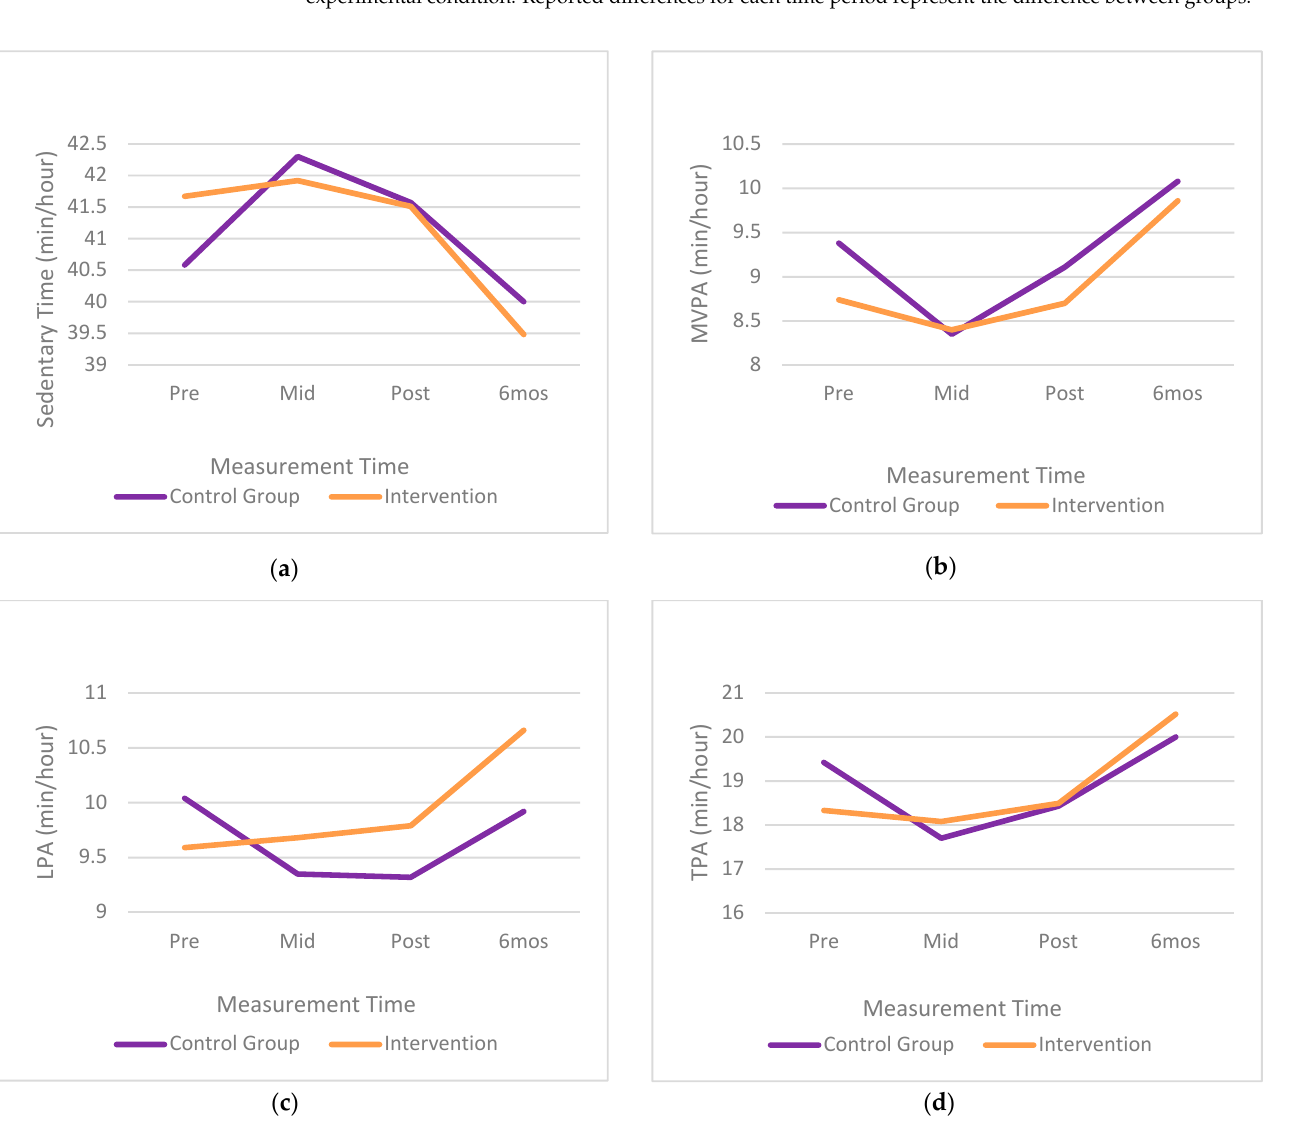
Figure 2. ( a – d ). Interaction plots for young children’s activity levels ( a ) sedentary time, ( b ) moderate-to-vigorous physical activity, ( c ) low physical activity, ( d ) total physical activity.